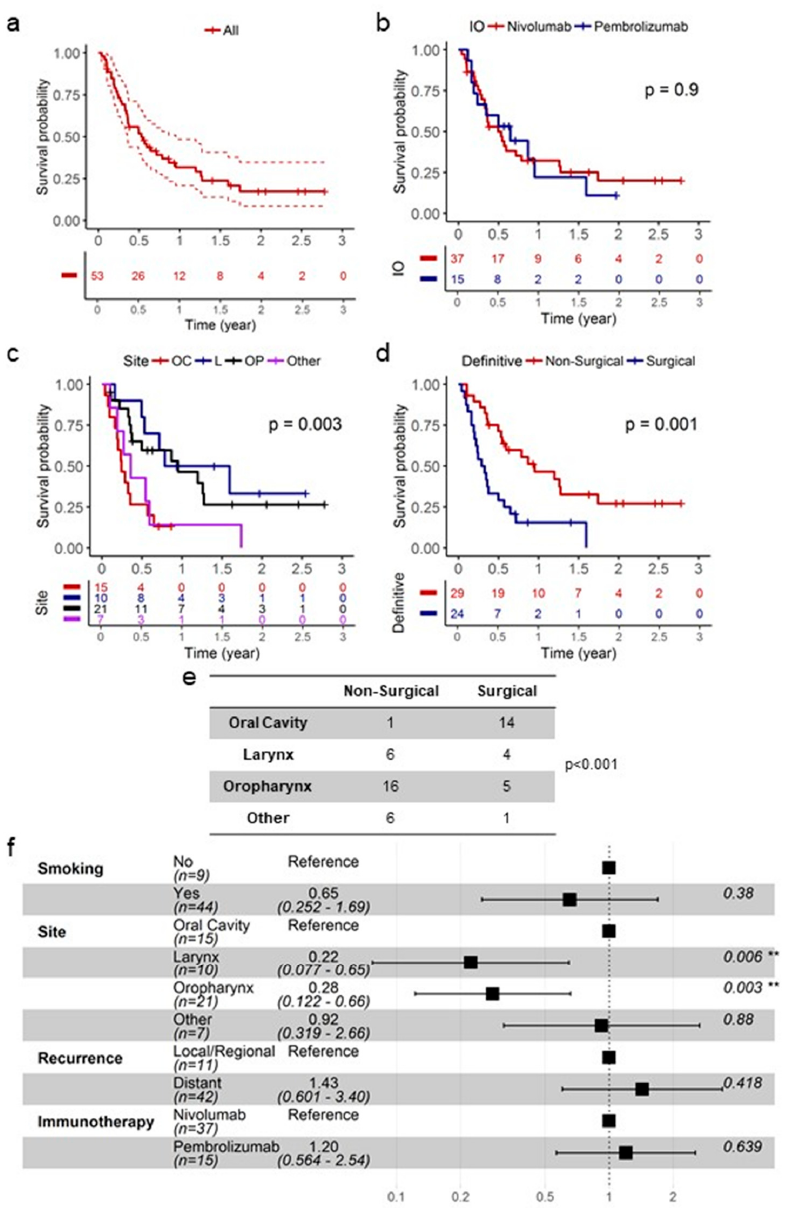
Figure 1. Anatomical site is associated with OS in immunotherapy-treated R/M HNSCC patients. ( a ) KM plot for the entire cohort. ( b ) KM plot based on anti-PD-1 immunotherapy choice. ( c ) KM plot based on anatomical site. ( d ) KM plot based on initial treatment approach. ( e ) Initial treatment approach based on anatomical site. ( f ) Multivariate model for the entire cohort presented as a forest plot. ** p <